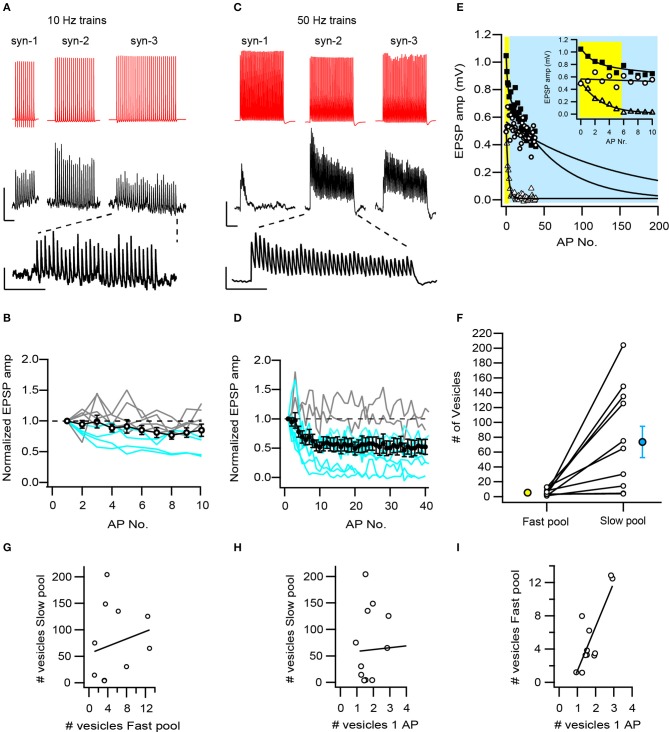
Temporal dynamics of L5B-L5B synapses are generated by different combinations of vesicle pools. (A) Constant synaptic responses are commonly observed during low-frequency trains (10 Hz) of APs. Averaged EPSP trains from three synaptic connections show constant or slightly depressing amplitudes. A typical EPSP train is shown enlarged. Scale bars: 47 and 0.4 mV for the AP and EPSP, respectively and 500 ms, same for the enlarged EPSP train. (B) L5B-L5B synapses typically exhibit constant synaptic transmission during 10 Hz trains of APs. Open circles represent the averaged responses of 11 synaptic connections, individual facilitating and constant connections are represented by gray curves and depressing connections by the blue curves. (C) Depressing synaptic responses dominate at high-frequency (50 Hz) trains. Averaged EPSP traces from 3 synaptic connections (same as A) exemplify different response patterns: rapidly, slowly- and non-depressing EPSP amplitudes. A typical pattern is plotted enlarged. Scale bars: 35 and 0.4 mV for the AP and EPSP, respectively and 200 ms, same for the enlarged EPSP train. (D) On average, EPSPs depressed mildly during high-frequency trains (black circles with error bars, n = 11). However, the individual synaptic responses vary from facilitation (gray curves) to strong depression (blue curves). (E) Fit of the EPSP amplitudes during high-frequency trains to a double-exponentially decaying function with a fast and a distinct slow time constants. Three individual synapses are plotted and fitted (triangles, squares, and circles for syn-1, syn-2, and syn-3, respectively). The fitted area under the fast and slow exponential decay time constants are shaded yellow and blue, respectively. The inset shows the first 10 EPSPs in the train. Note, that in each synapse the fitted area was dominated either by the fast or the slow processes or by both. (F) Two pools of vesicles account for the temporal dynamics of L5B-L5B synapses during high-frequency trains: a rapidly recruited and depleted pool containing on average 5.4 (yellow circle) and a slowly depleted pool containing 74 (blue circle) vesicles. At individual synapses (open circles) the slow pool varied dramatically in size. (G) The fast and slow vesicular pools are not correlated with each other at individual synapses (R2 = 0.04, P = 0.55). (H) The slow pool is not correlated with the number of vesicles released during a single AP. (I) The number of vesicles released during a single AP is highly correlated with the size of fast pool (R2 = 0.67, P = 0.002).